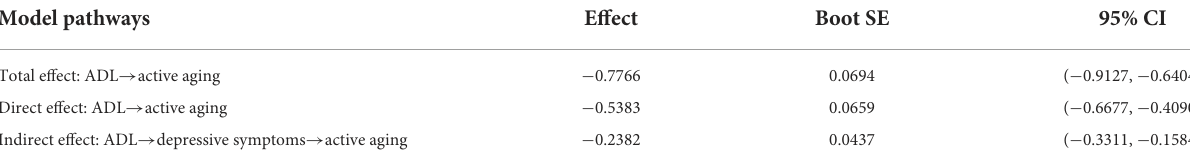
TABLE 2 Mediating effect of depressive symptoms between ADL and active aging. Model